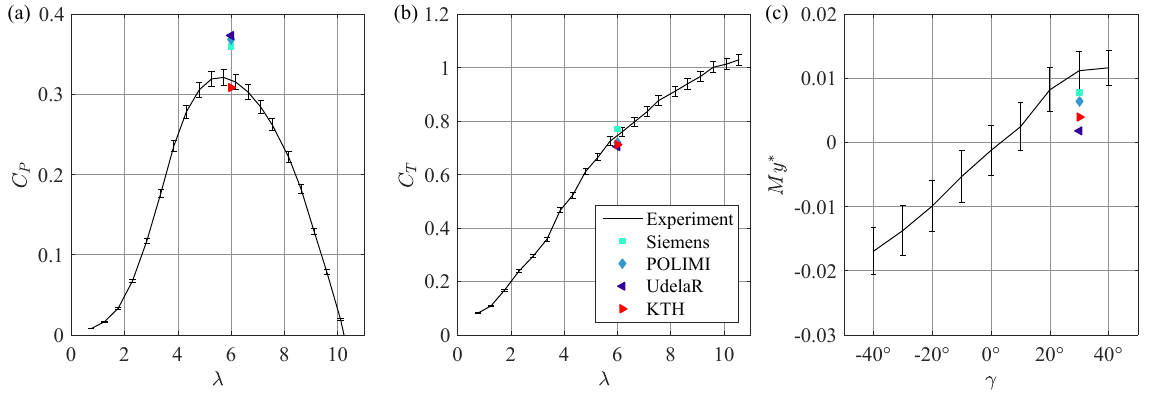
Figure 6. Power coefficient C P , LARS1 (a) and thrust coefficient C T , LARS1 (b) for the upstream turbine LARS1 operated at γ LARS1 = 30 ◦ (c) for the upstream turbine LARS1 operated at λ LARS1 = 6 for γ = − 40 ◦ to + 40 ◦ . and normalized yaw moment M ∗ y, LARS1